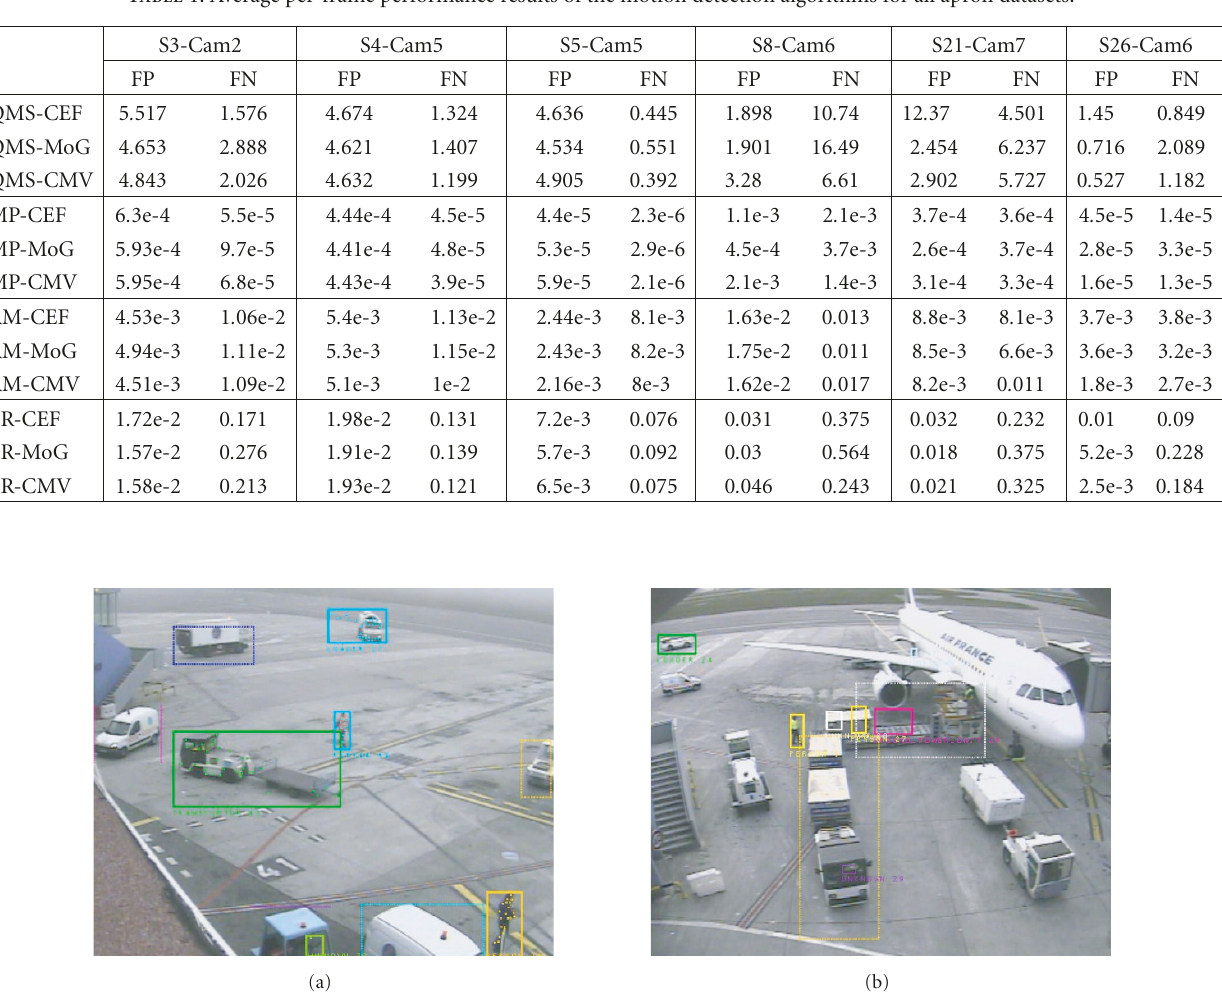
Table 1: Average per-frame performance results of the motion detection algorithms for all apron datasets.